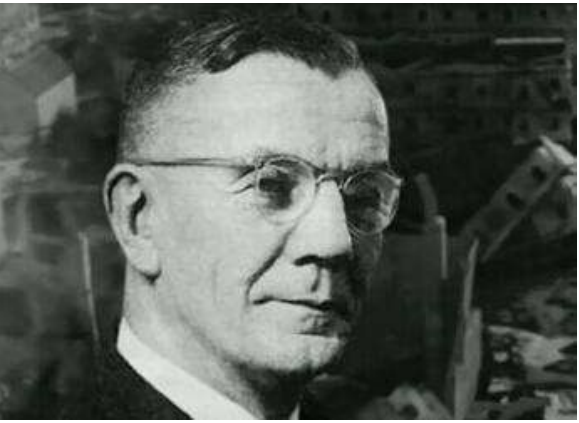
Figure 4. Miner Searle Bates.